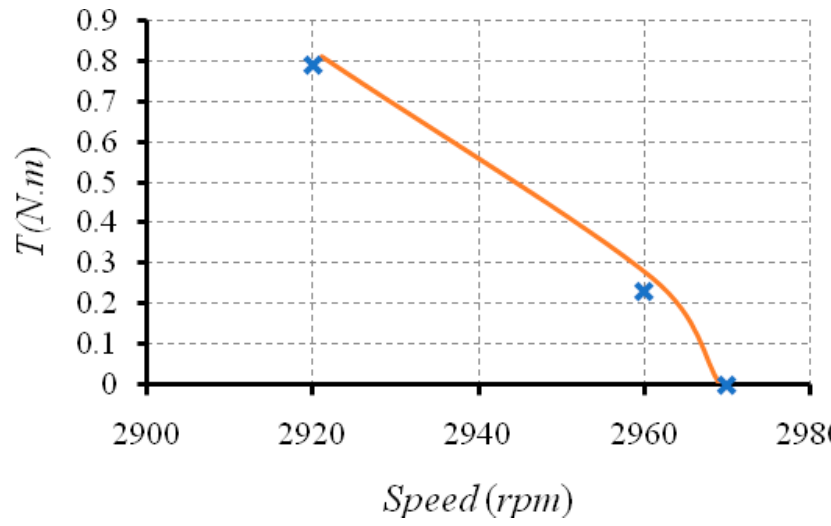
Figure 16. Torque–speed characteristics of six-phase motor ( − simulation, x experimental).